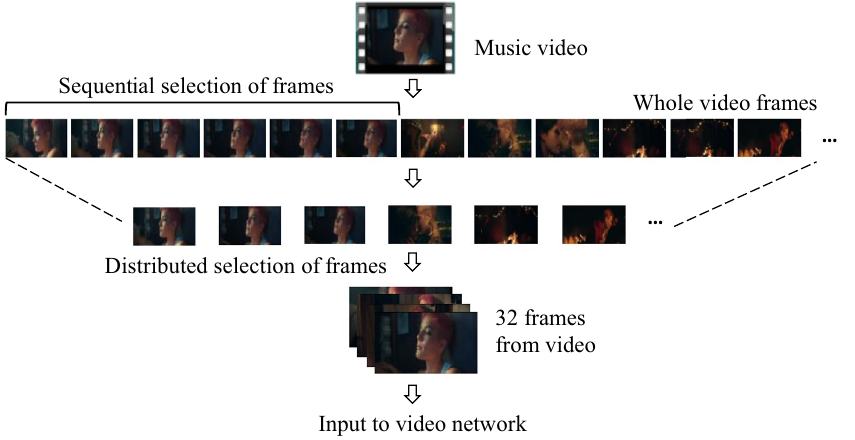
Figure 1. Input video processing using distributed selection of frames. The video frames are from the first 30 s of the music video “Without Me” (https:// www. youtu be. com/ watch?v= ZAfAud_ M_